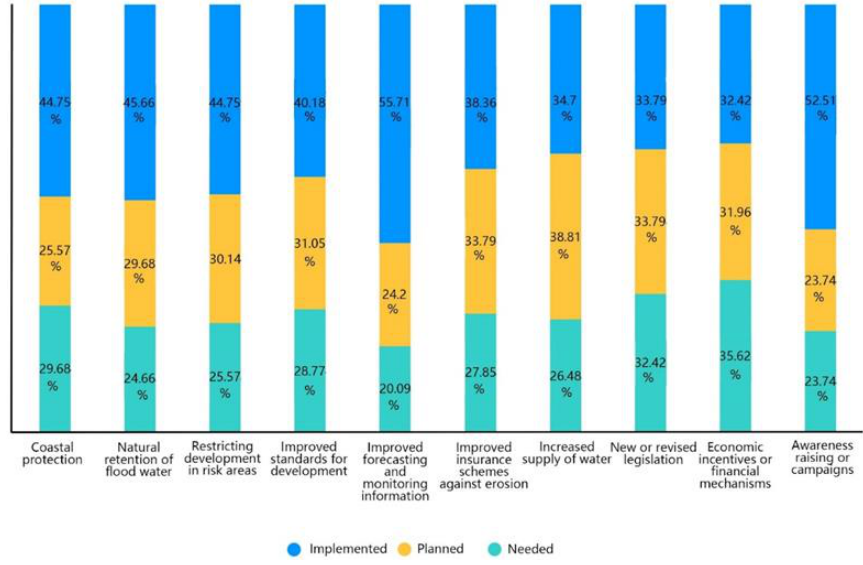
Figure 12. Participants ’ views on the hazards of climate change and urban vulnerability.